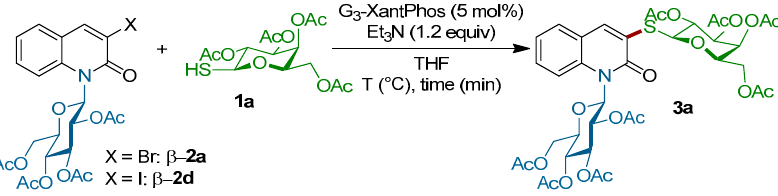
2. Coupling of the quinolones β - 2a and β - 2d with tetra - O -acetylated 1-thio- β - D -galactopyranose 1a under various reaction conditions. 1. Survey of reaction conditions for the coupling of tetra- O -acetylated